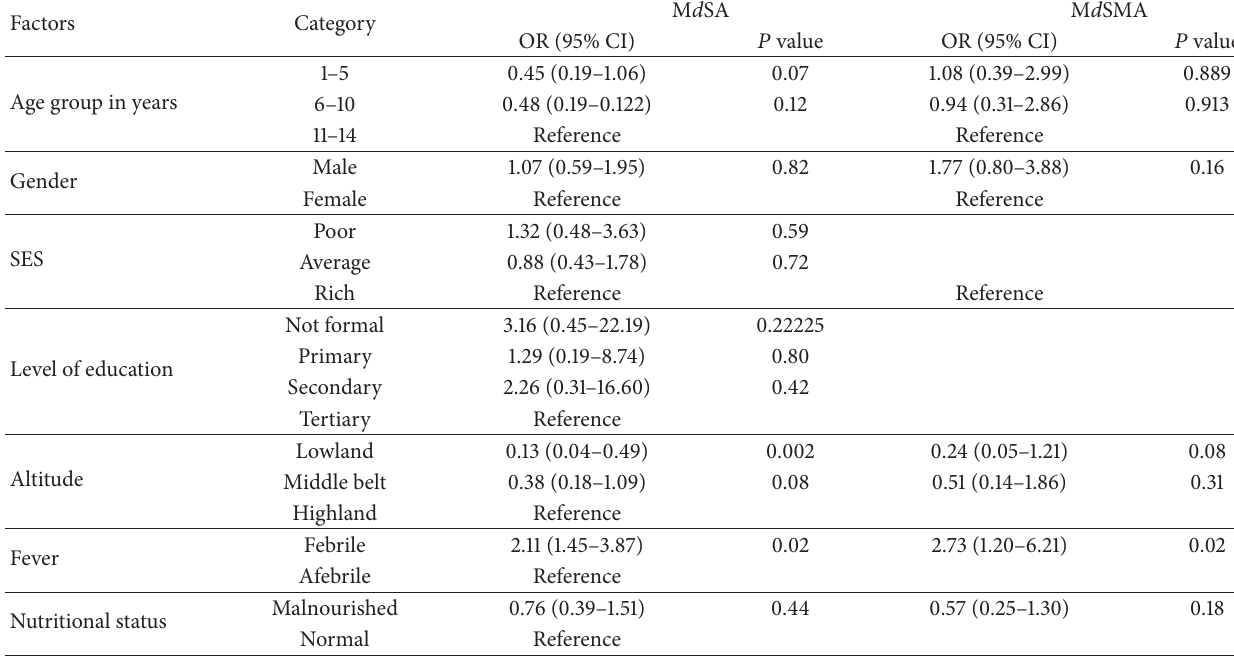
Table 3: Multinomial logistic regression analysis examining sociodemographic and clinical factors influencing M d SA and M d SMA.